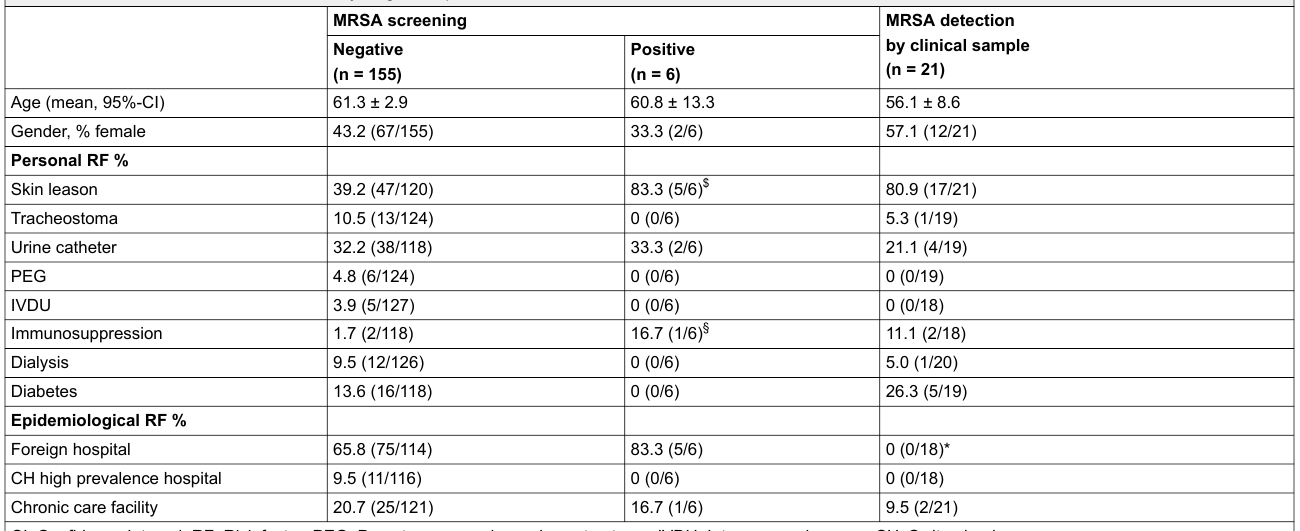
Table 1: Risk factors in screened and clinically diagnosed